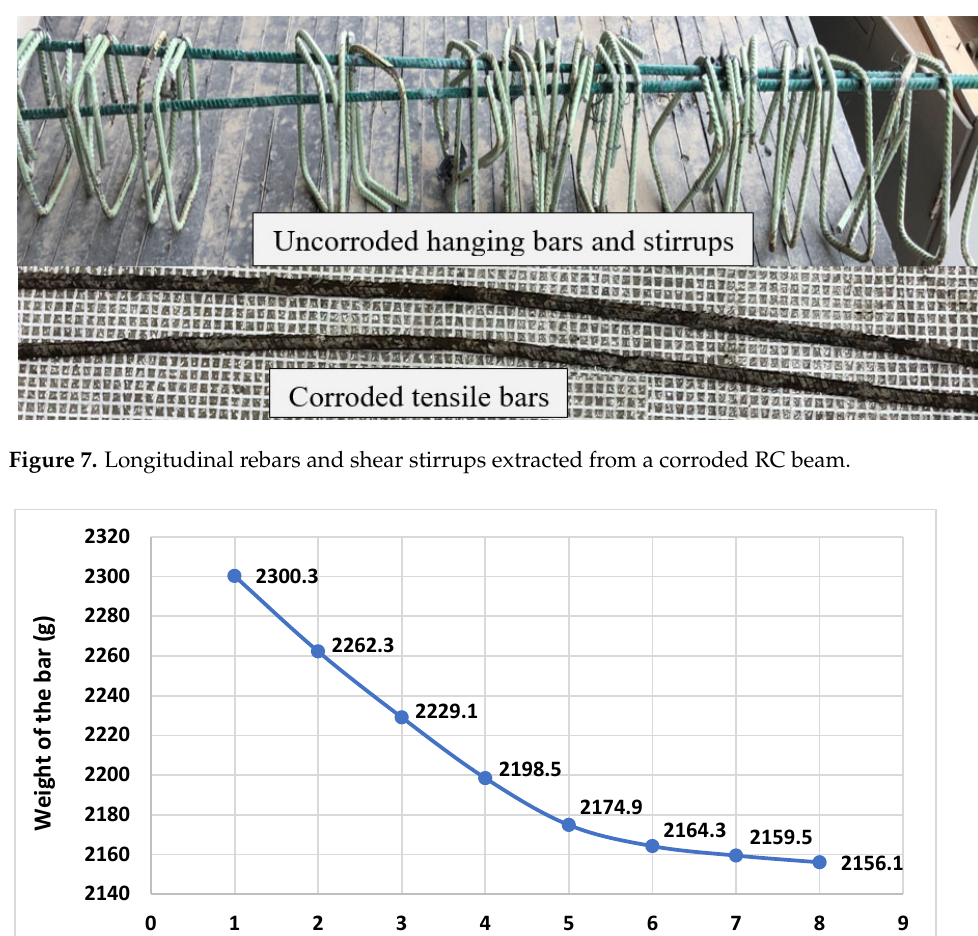
Figure 6. Extraction of the corroded bars from the beam.